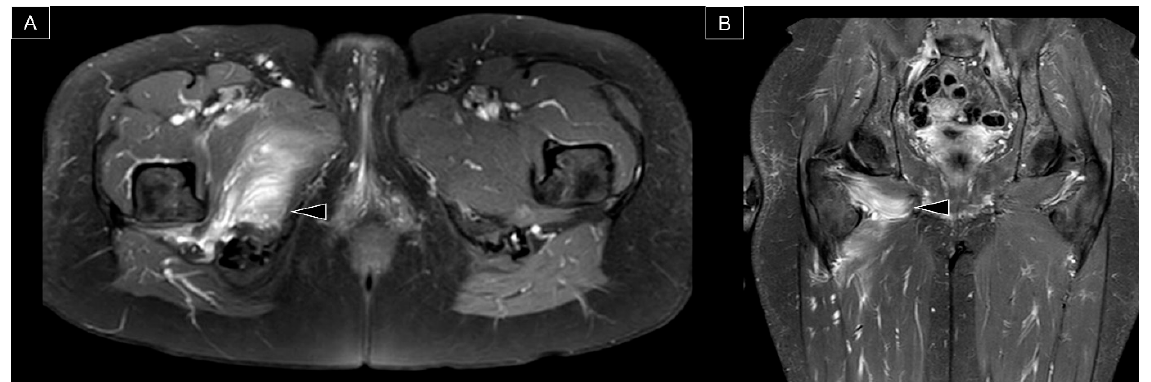
Figure 8. ( A ) Axial and ( B ) coronal views of T2 weighted MRI in a case with IIS. The arrows indicate swelling and perifocal edema of the quadratus femoris muscle.